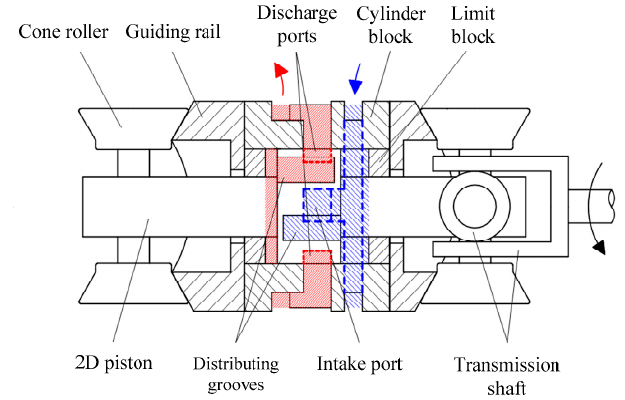
Figure 1. Mechanical structure of the traditional 2D piston pump.